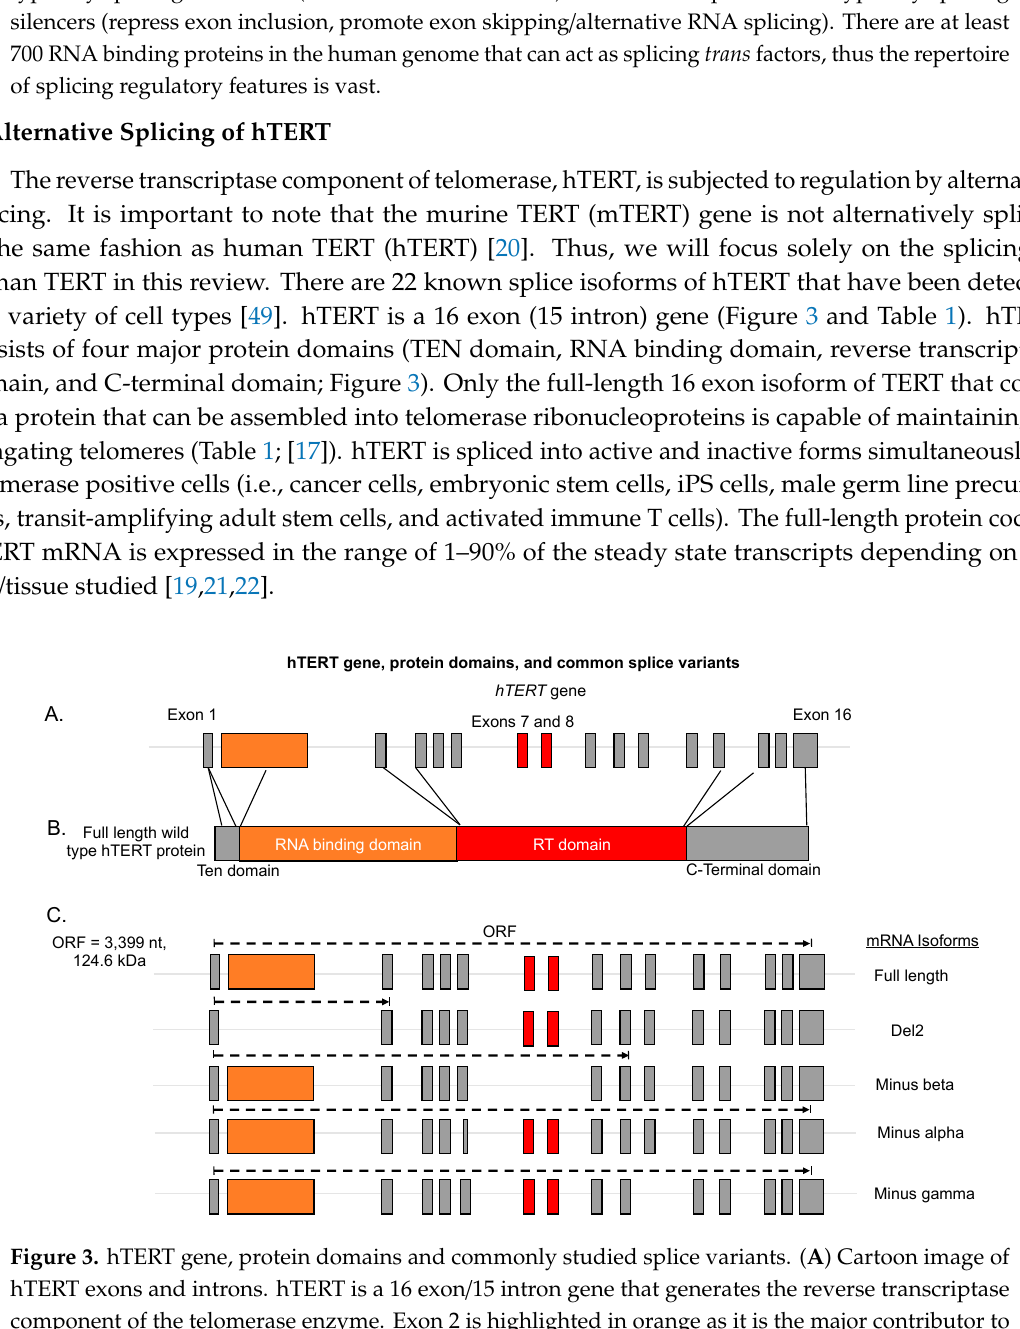
Figure 2. Alternative splicing regulation. A cartoon image of important sequence ( cis ) and protein ( trans ) regulatory features that result in exon inclusion or exclusion. The majority of the splicing information is contained in intronic and exonic sequences that are called intronic splicing contained in intronic and exonic sequences that are called intronic splicing silencers / enhancers (ISS / ISE) silencers/enhancers (ISS/ISE) and exonic splicing silencers/enhancers (ESS/ESE). Specialized RNA and exonic splicing silencers / enhancers (ESS / ESE). Specialized RNA binding proteins bind to these binding proteins bind to these sequence elements and recruit in the megadalton spliceosome. sequence elements and recruit in the megadalton spliceosome. Serine / Arginine-Rich (SR) proteins are Serine/Arginine-Rich (SR) proteins are typically splicing enhancers (enhanced exon inclusion) while typically splicing enhancers (enhanced exon inclusion) while hnRNP proteins are typically splicing hnRNP proteins are typically splicing silencers (repress exon inclusion, promote exon silencers (repress exon inclusion, promote exon skipping / alternative RNA splicing). There are at least skipping/alternative RNA splicing). There are at least 700 RNA binding proteins in the human 700 RNA binding proteins in the human genome that can act as splicing trans factors, thus the repertoire genome that can act as splicing trans factors, thus the repertoire of splicing regulatory features is vast.